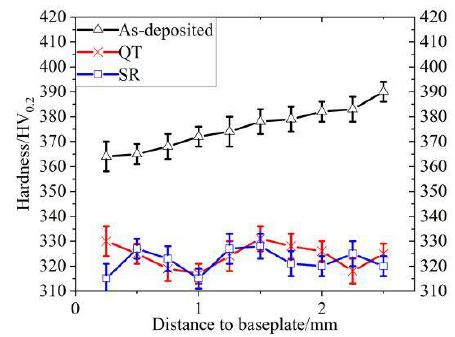
Figure 8. Hardness of samples in different states.